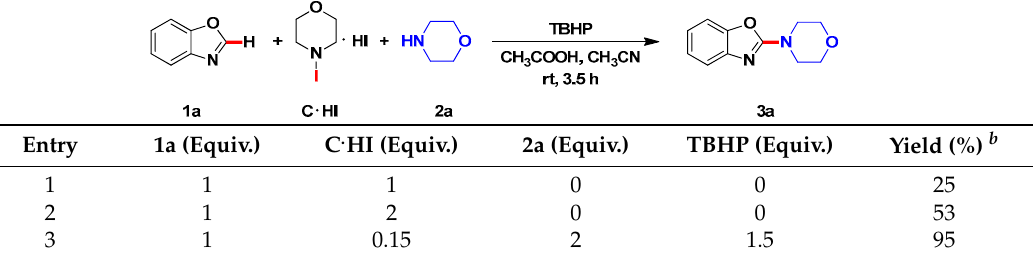
Figure 1. Recycling reactions. In order to elucidate the reaction mechanism, control experiments were carried out. When the radical scavenger BHT (2,6-di- tert -butyl-4-methylphenol, 3 equiv.), ethene-1,1-diyldibenzene (3 equiv.), or TEMPO (2,2,6,6-tetramethylpiperidine- N -oxyl, 3 equiv.) were added to the reaction mixture under the optimal conditions, the yield of 3a was not decreased. Thus, the reaction may not be a radical reaction. Subsequently, N -iodomorpholine hydroiodide was prepared. Then, the reaction of benzoxazole (0.672 mmol, 1 equiv.) and N -iodomorpholine hydroiodide (0.672 mmol, 1 equiv.) with acetic acid (2.016 mmol, 3 equiv.) as an additive in 2 mL CH 3 CN at room temperature for 3.5 h afforded the desired product 3a in 25% yield (Table 2, entry 1). When the dosage of